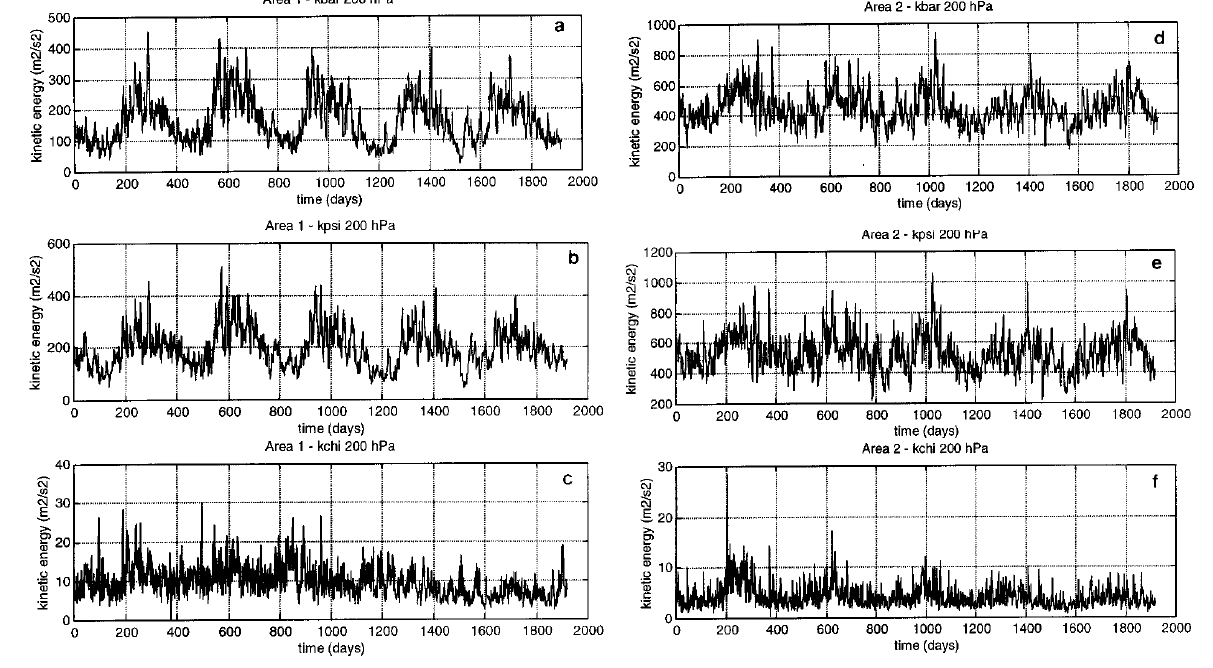
Fig. 2. Temporal variations of the kinetic energy (m 2 s − 2 ) at 200 hPa, mean for tropical South America: ( a ) K , ( b ) K ψ , ( c ) K χ , and extratropical South America: ( d ) K , ( e ) K ψ and ( f ) K χ . Zero represents 1 November 1985.